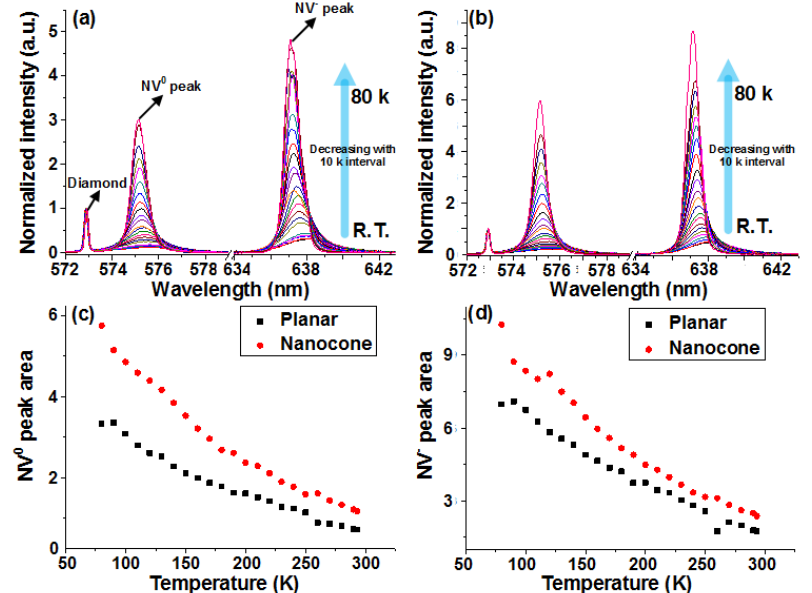
Figure 5. Normalized and baseline corrected, magnified photoluminescence spectra of samples with ( a ) planar and ( b ) nanocone surfaces range from room temperature to 80 K, respectively. The peak areas for ( c ) N-V 0 and ( d ) N-V − changed as the temperature cooled.